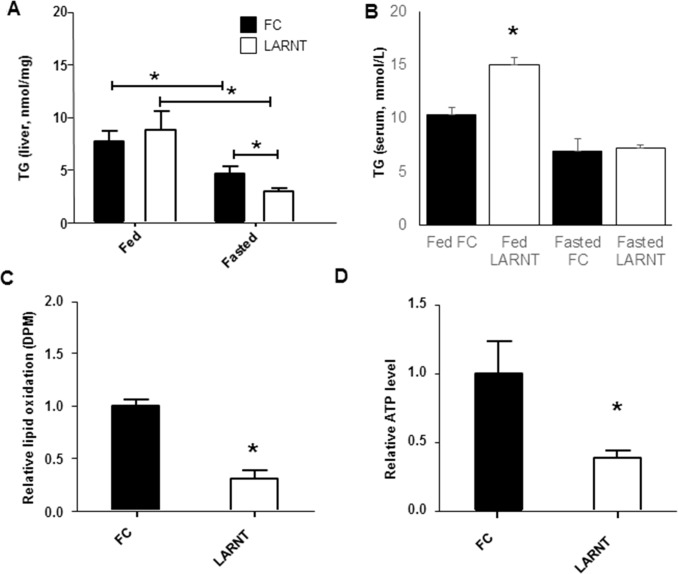
Triglyceride (TG) handling and ATP in LARNT mice.(A) Liver TG in FC and LARNT male mice before (Fed) and after a 16hr fast (Fasted). (B) TG in serum 6 hours after feeding (Fed) or after a 16 hour fast (Fasted). (C) Lipid oxidation in isolated hepatocytes from FC or LARNT animals. (D) Whole liver ATP levels in fasted LARNT compared to FC animals. Columns indicate mean±SEM. * = p<0.05. N = 5–6 per group.